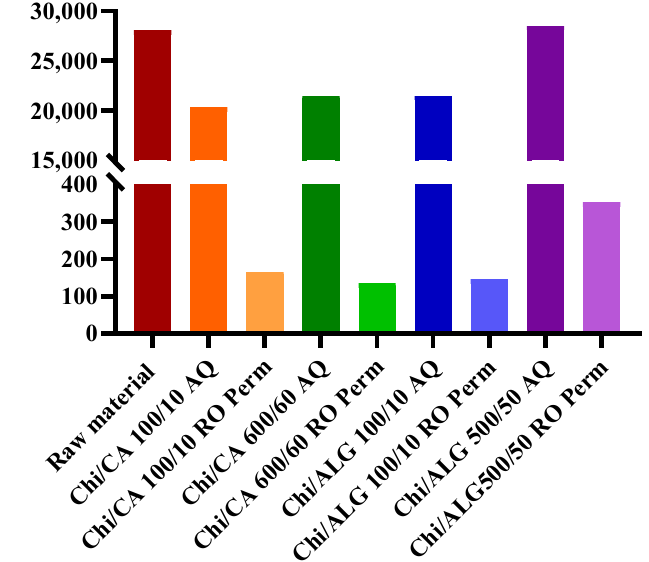
Figure 13. Effect of integrated system of coagulation/flocculation followed by reverse osmosis on the COD of the permeates.